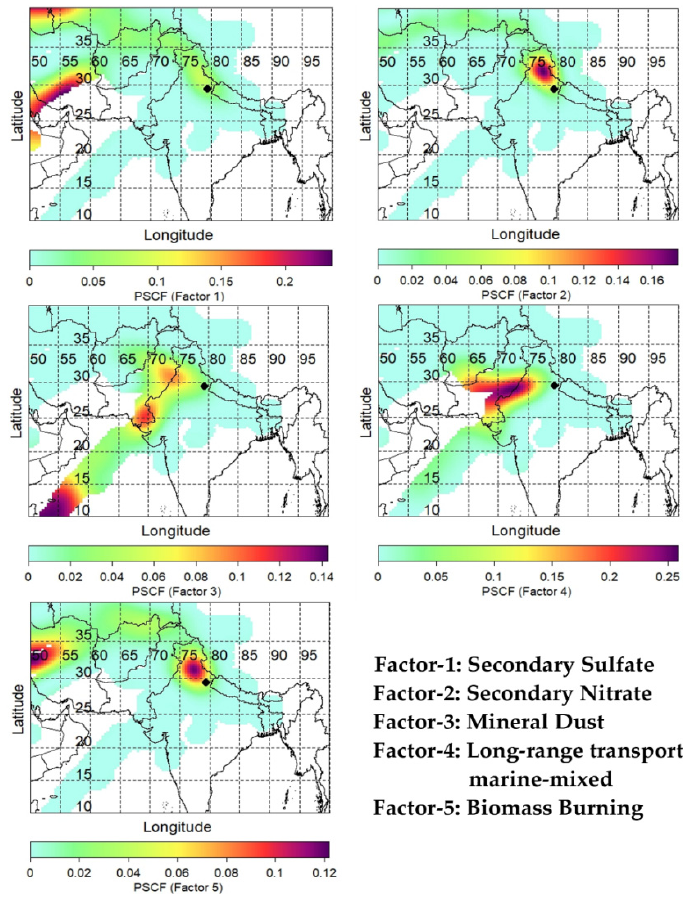
Figure 8. Potential source origins of PMF-identified aerosol sources, resolved by potential source contribution function (PSCF) analysis. The black dot shows the location of the measurement site.